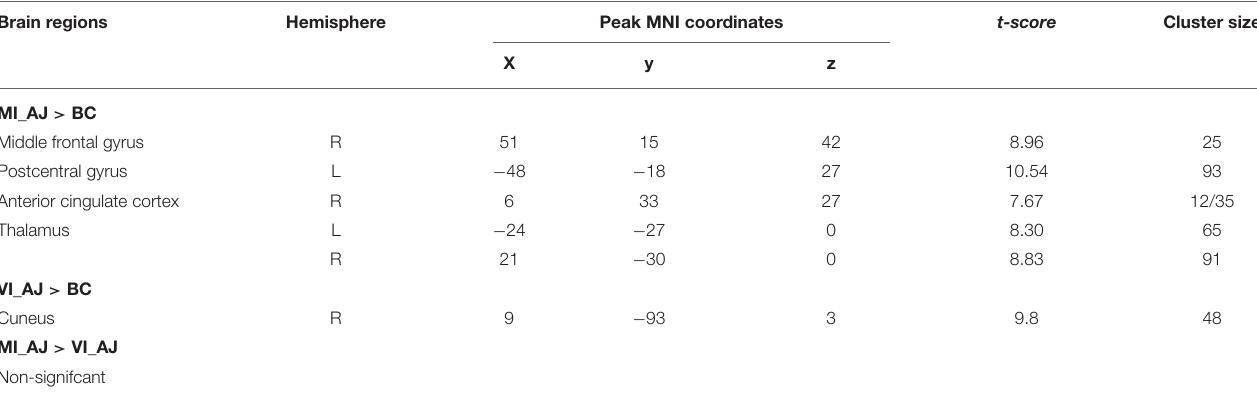
TABLE 3 | Brain activated during aesthetic judgment for the contrast kinesthetic/visual/automatic